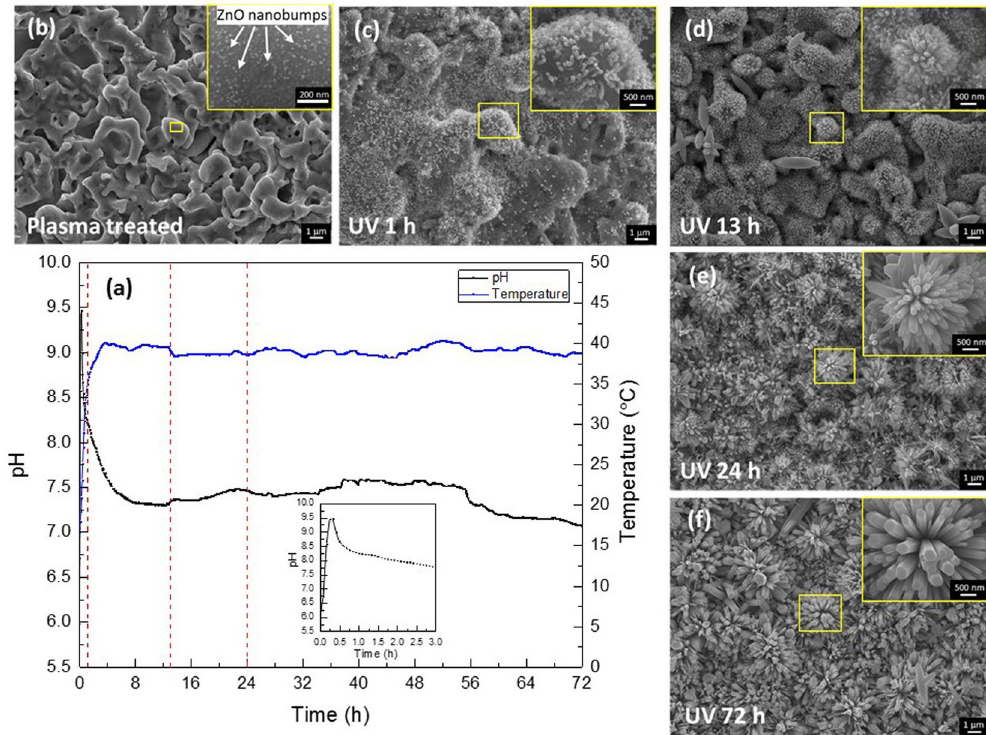
Figure 1. ( a ) Time dependence of the pH and temperature of ultrapure water during the UV-irradiation SPSC experiment. The inset is a magnified view of the pH change over a period of 3 h. ( b ) SEM image of the surface of plasma-treated Zn plate. ( c–f ) SEM images of the surface of the Zn plate after different UV irradiation times (1 h, 13 h, 24 h, and 72